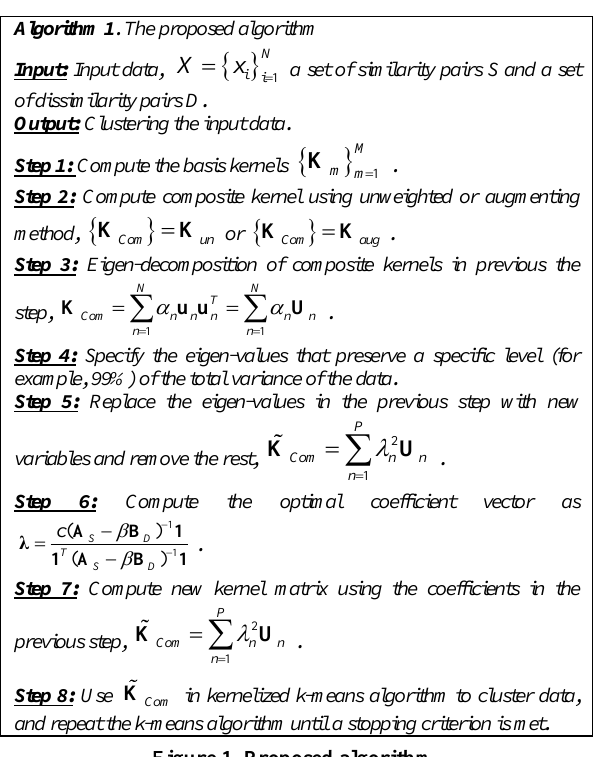
Figure 1. Proposed algorithm.